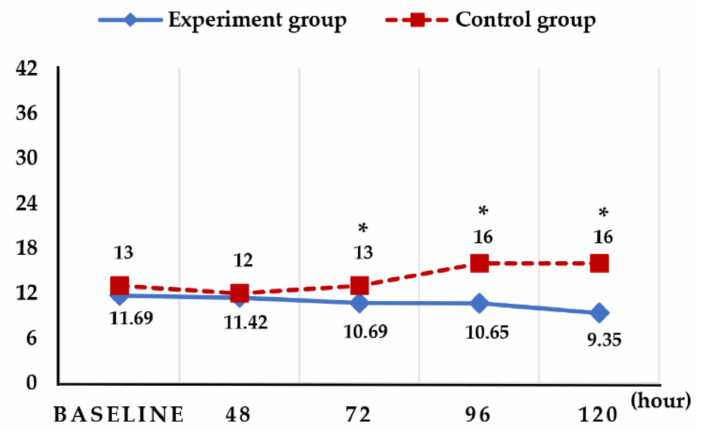
Figure 2. Changes in the M-BOE score. As a result of analyzing the difference in BOE score between rounds, there was no significant difference between the experimental group and the control group at 24 and 48 h, but there was a significant difference between the two groups at 72, 96, and 120 h (an